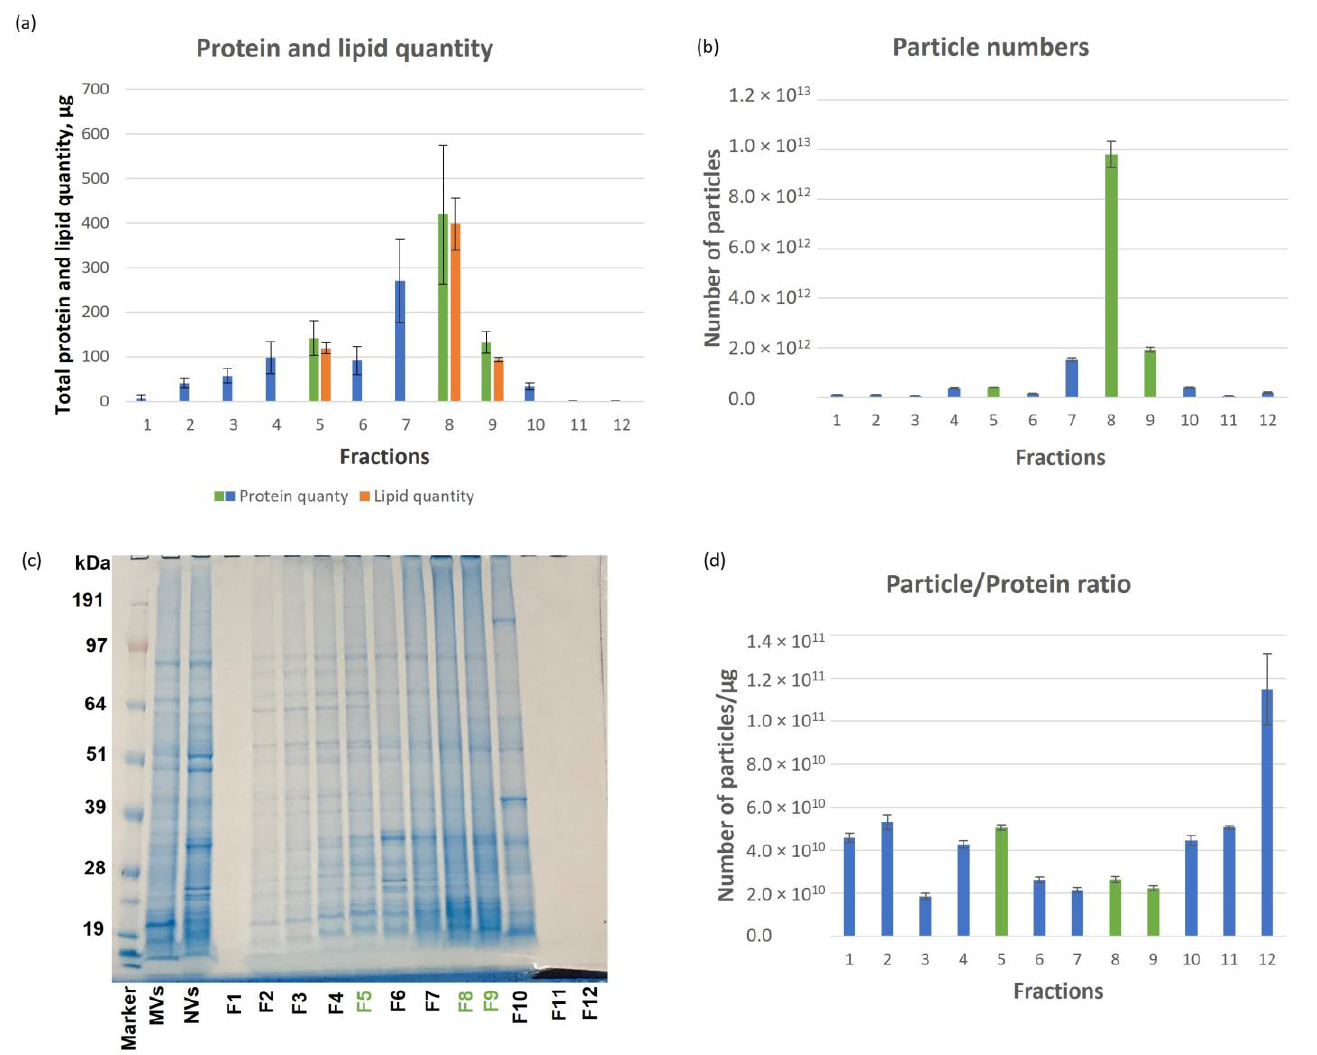
Figure 2. Physical and molecular characteristics of the tomato NVs subpopulations. ( a ) The distribution of protein quantity over the iodixanol density gradient ultracentrifugation (DGUC) fractions (normalized for 1 mg of loaded NVs sample, n = 3); ( b ) number of particles in each fraction; ( c ) sodium dodecyl sulfate – polyacrylamide gel electrophoresis protein profiles of tomato NVs and fractions separated by iodixanol DGUC (the loaded protein quantity for each fraction was 10 µg, except Fraction 1, 11 and 12, for these fractions the protein amount was around 1 µg); ( d ) the particle to protein ratio in each fraction.